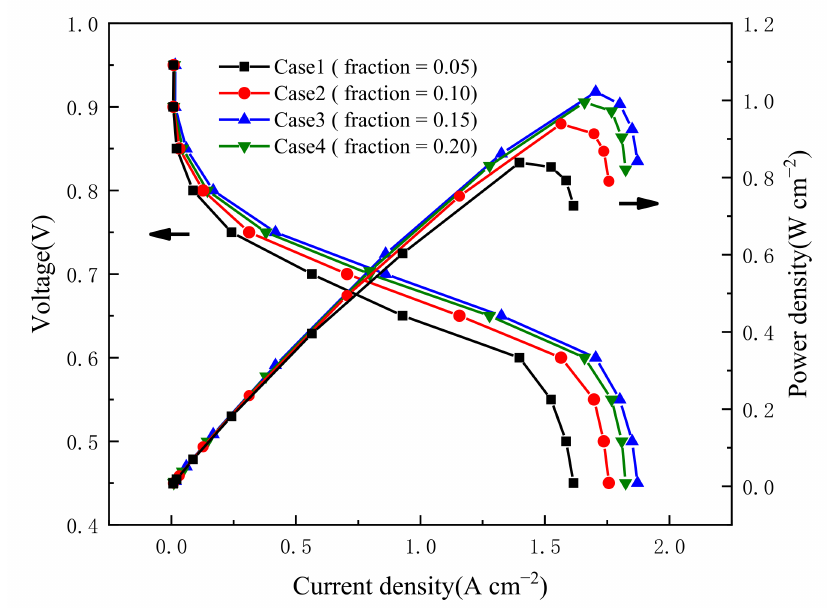
Figure 11. Effect of ionomer volume fraction on cell performance.